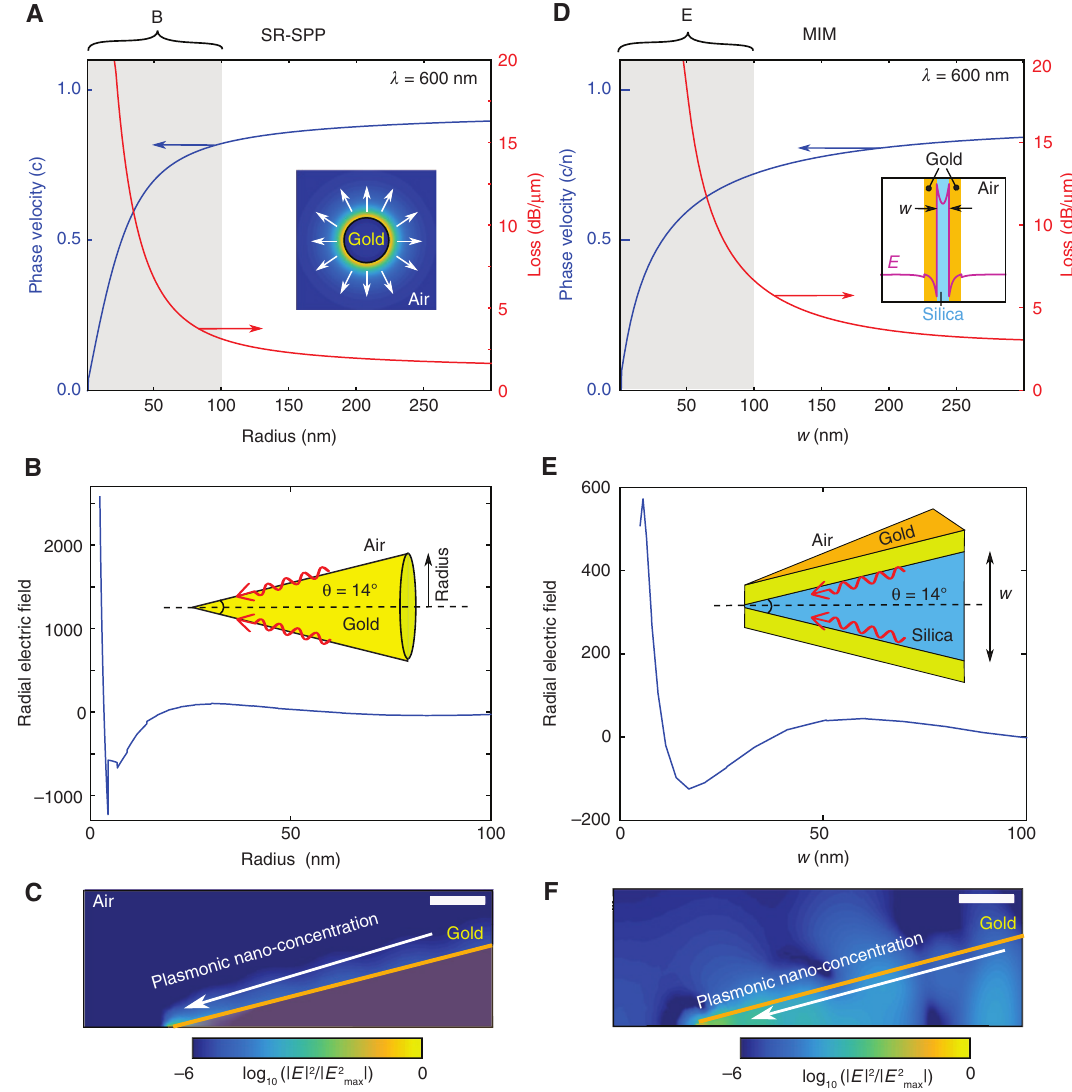
Figure 3: Fiber-compatible schemes for plasmonic nanoconcentration at the end-faces of optical fibers. (A) Phase velocity normalized to the speed of light in vacuum (blue) and modal loss (red) of the RP plasmonic mode (inset) for a gold nanow- ire surrounded by air as a function of local radius. (B) Calculated electric field amplitude of the RP electric mode as a function of the tip radius, showing plasmonic enhancement. (C) Finite element simulations of the intensity for a mode propagating toward the apex of a gold nanocone (apex radius: 2.5 nm). (D) Phase velocity normalized to the speed of light in silica ( n = refractive index of silica; blue) and modal loss (red) of the linearly polarized mode supported by a metal-dielectric-metal structure as function of the silica slab width w . The structure consists of a silica slab surrounded two gold nanolayers (gold thickness: 100 nm). (E) Calculated electric field amplitude as a function of the waveguide width w and constant gold thickness through the central slice of the tapered MIM structure (dotted line), showing plasmonic enhancement. (F) Finite element calculations of the spatial distribution of the intensity for a mode propagating down the tapered MIM wave- guide in the dotted plane in (E). Scale bar (C and D), 200 nm. All calculations are performed at λ = 600